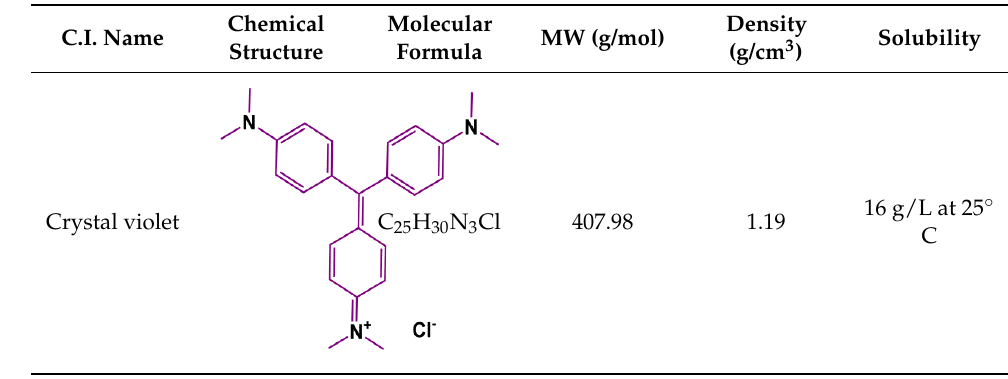
Table 1. Chemicals characteristics of crystal violet dye.